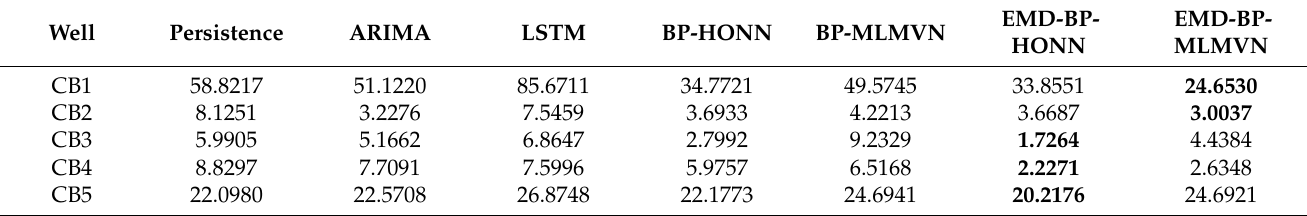
Table 4. Result of CB oilfield in MAPE metric. The lowest score is in bold.